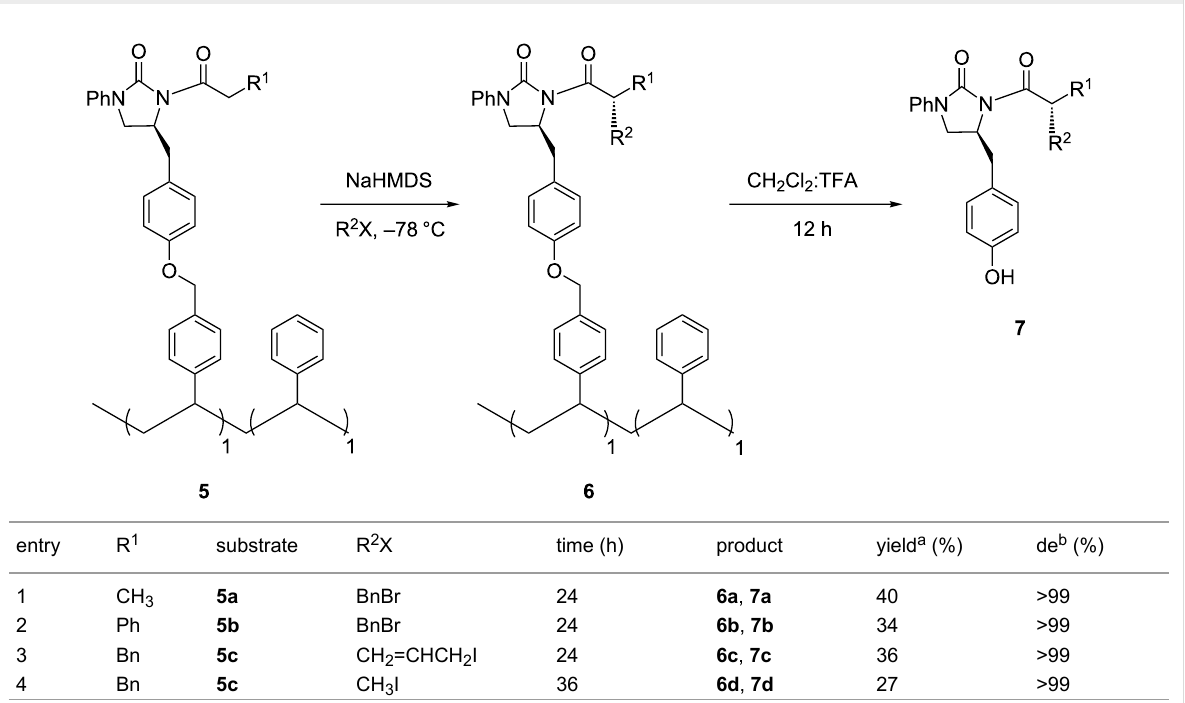
Table 3: Diastereoselective alkylations before TFA